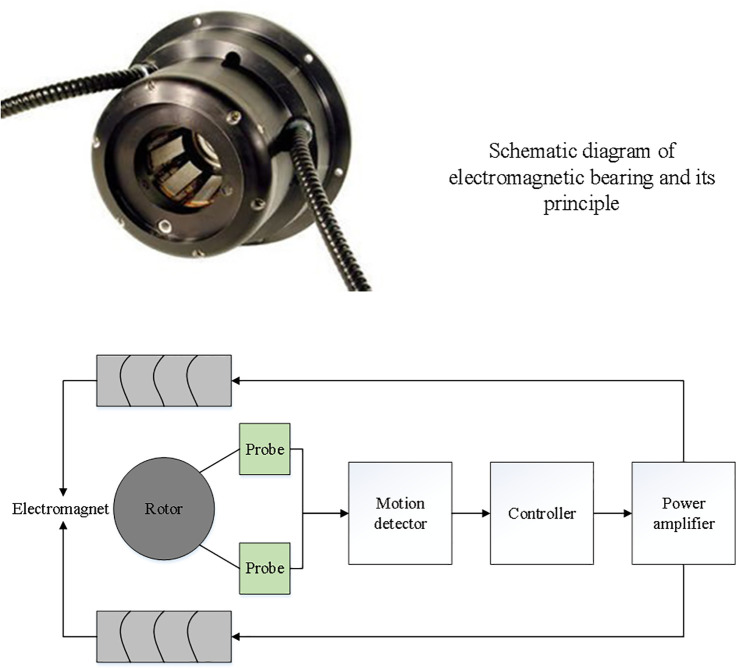
Schematic diagram of electromagnetic bearing and its working principle.